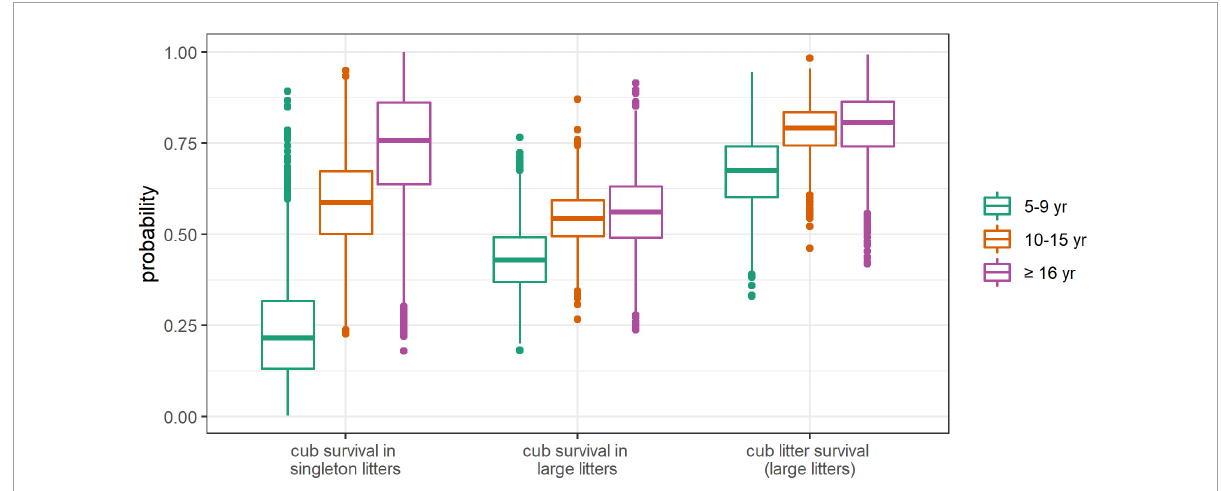
FIGURE8 Posterior distributions of first-year cub and litter survival probabilities depending on mother’s age. First-year survival corresponds to survival between the age of 3–4 months and the age of 15–16 months (i.e., between the cubs’ first spring and the following one). First-year litter survival (as opposed to whole litter loss) refers to at least one cub of a large litter